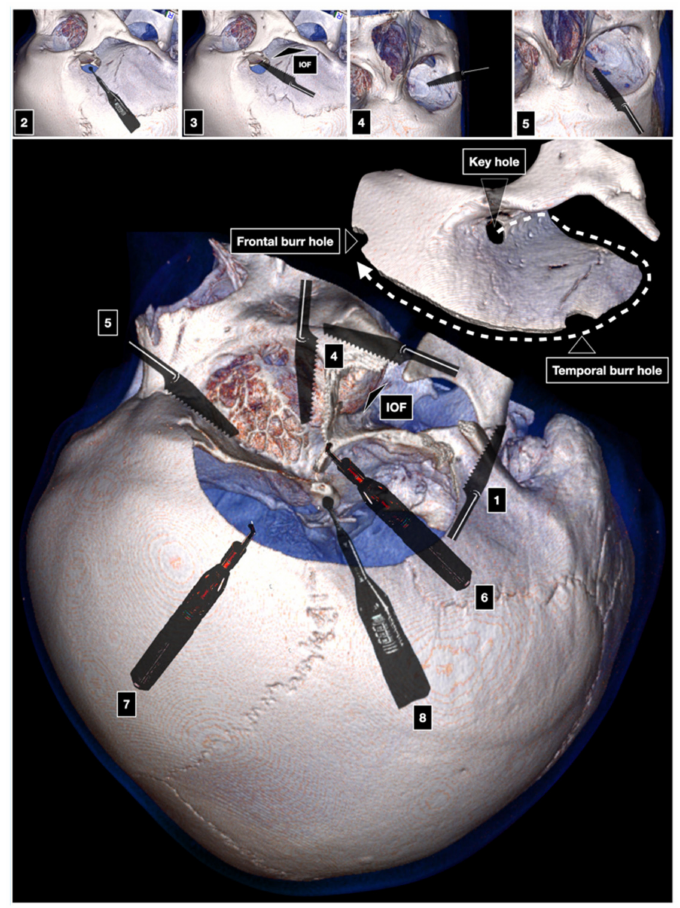
Figure 3. One-piece COZ approach. IOF: inferior orbital fissure. 1: first cut; 2: McCarty keyhole; 3: second cut; 4: third cut; 5: fourth cut; 6–7: connection of the keyhole with temporal and frontal burr hole; 8: anterior